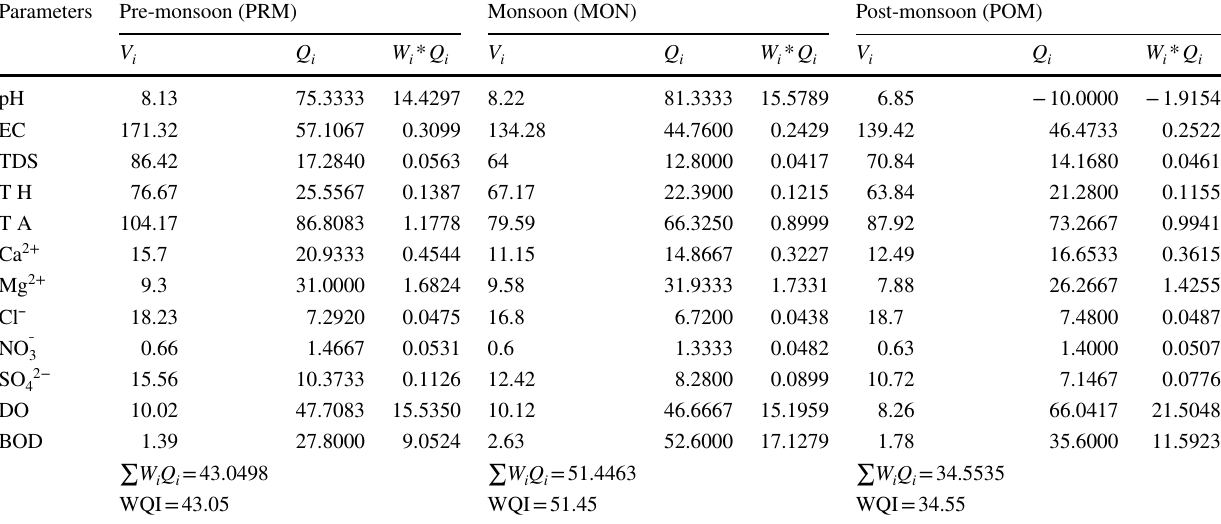
Table 9 Calculation of WQI at station 5 (S 5)